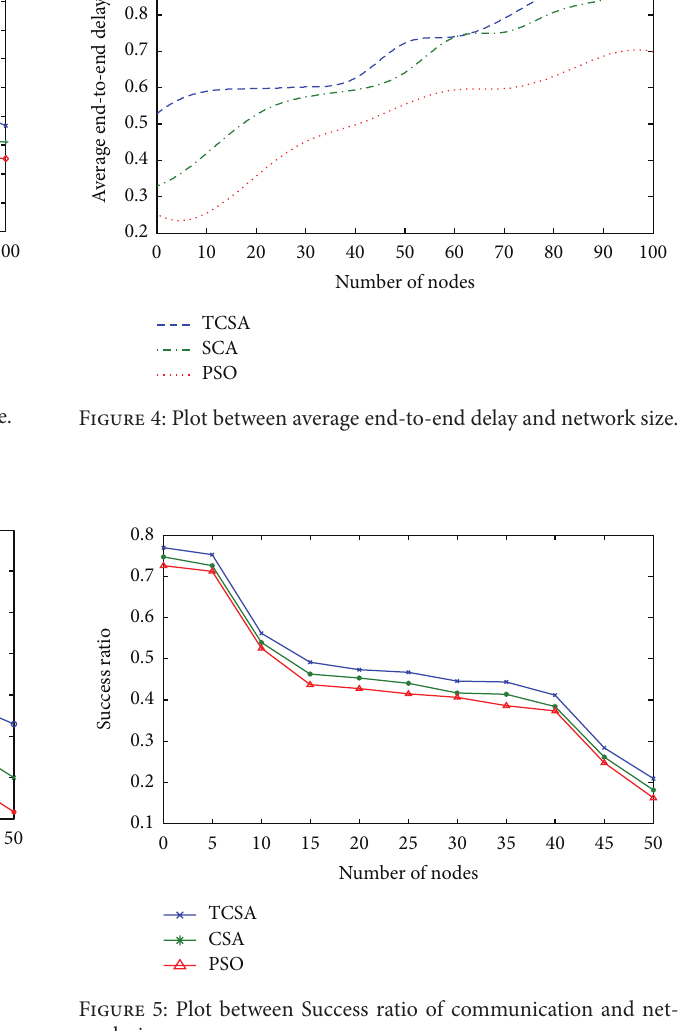
Figure 5: Plot between Success ratio of communication and net- work